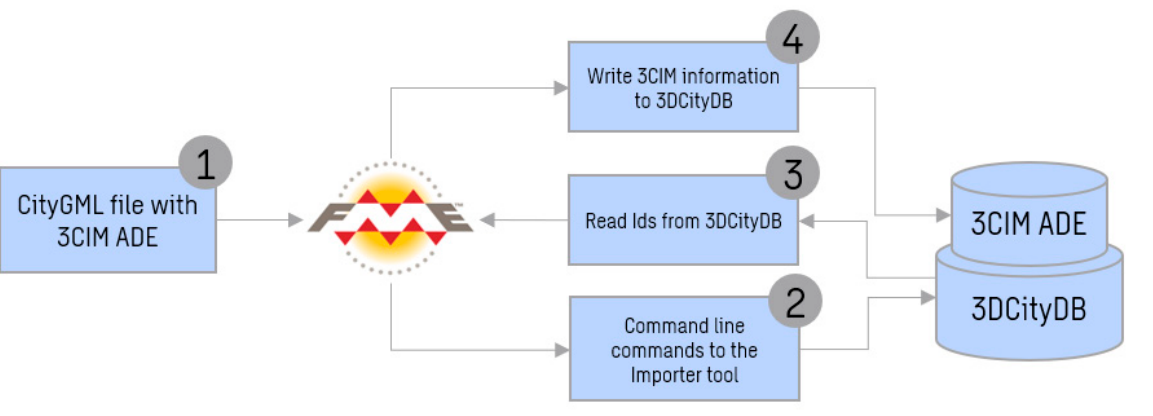
Figure 13. Workflow to save 3CIM data to 3DCityDB with an FME script and the Importer/Exporter tool in 3DCityDB. The numbers provide the order the process is executed.